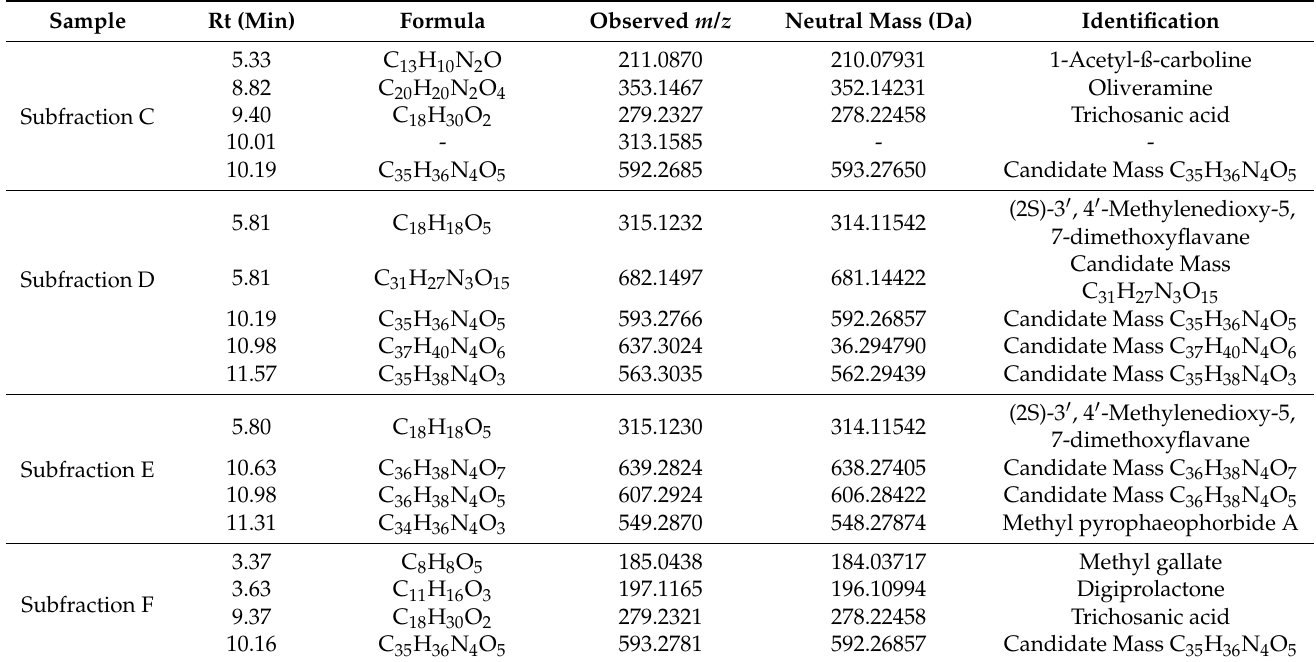
Table 1. The m/z profile of identified compounds in subfractions C, D, E, F of Sansevieria trifasciata Prain.